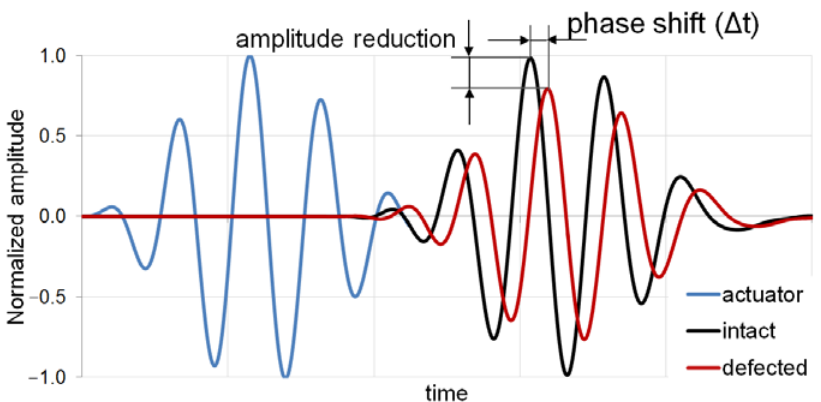
Figure 8. The schema of the excitation signal used and an example of the possible Lamb-wave response.